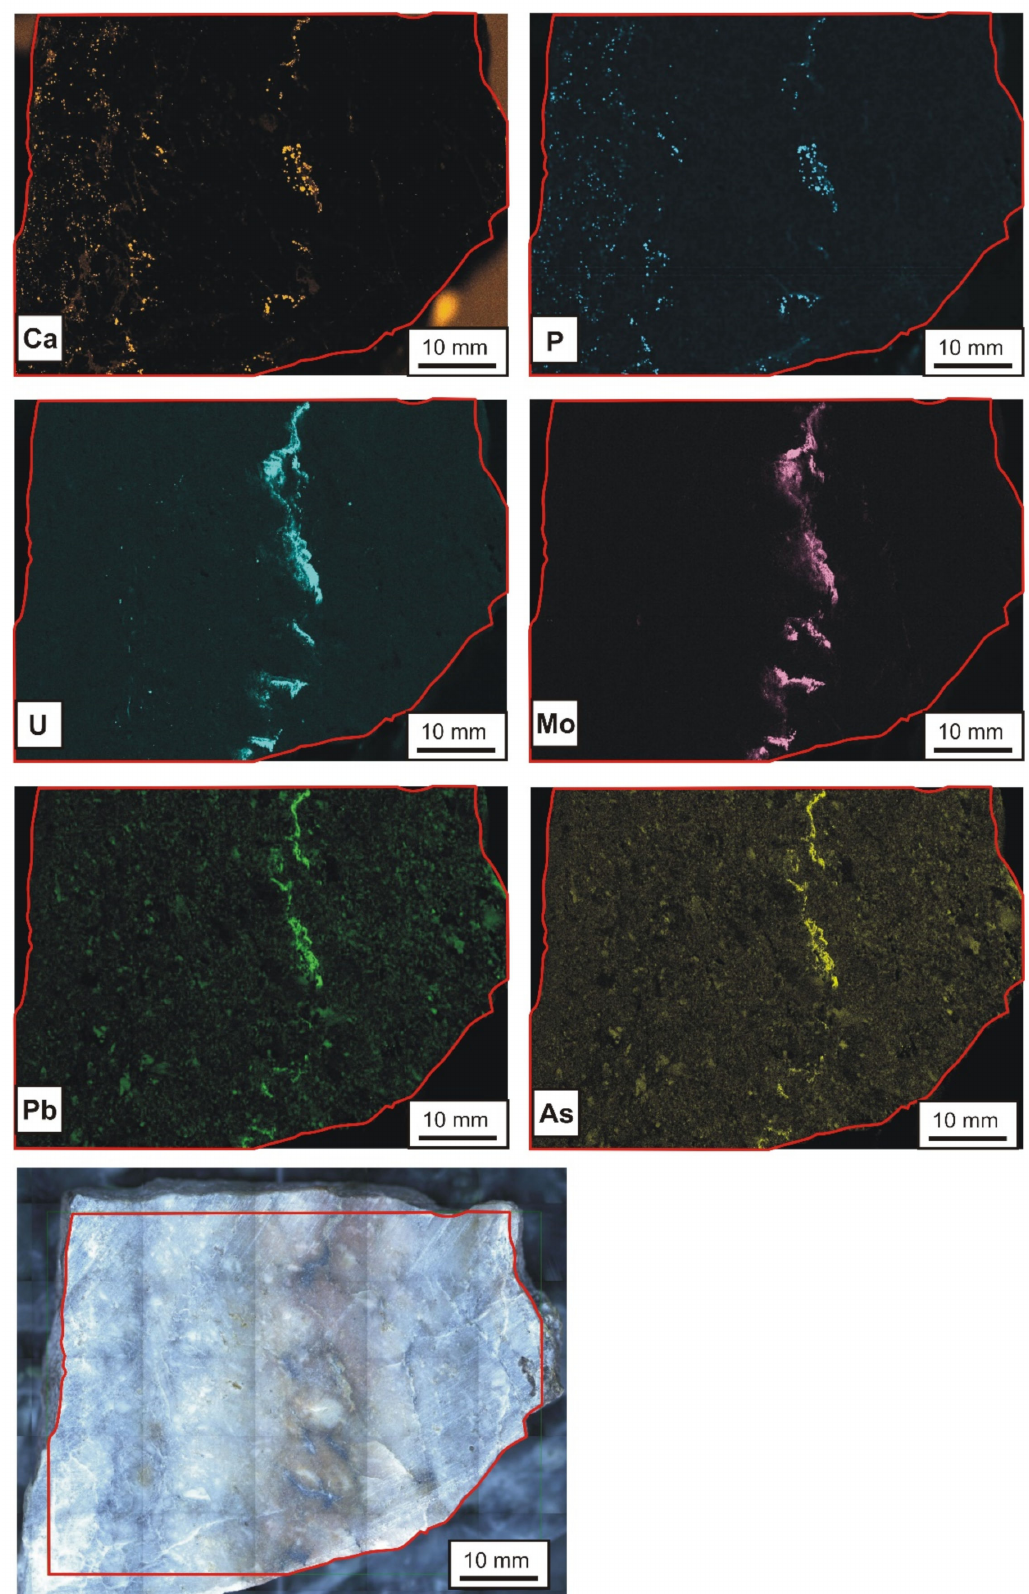
Figure 3. XRF distribution maps of selected elements in quartz vein with U-Mo mineralization (bottom subfigure). Ca and P indicate the distribution of accessory fluorapatite in quartz. Photo: S. Milovsk á